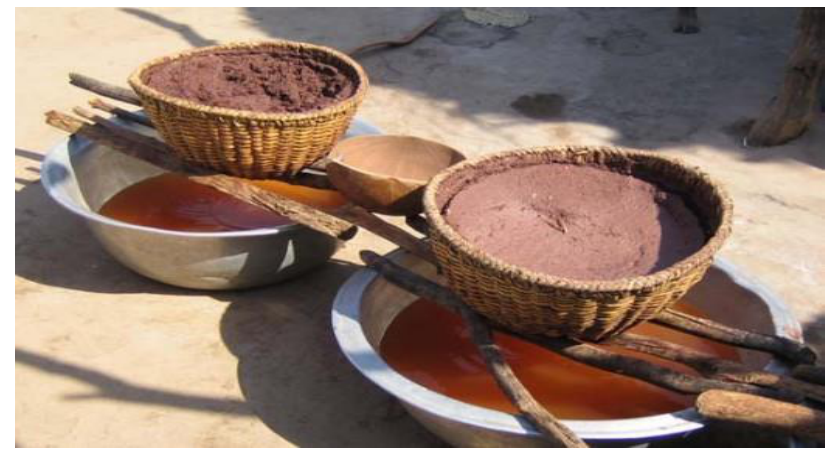
Figure 5. Indigenous method of lautering [136] .